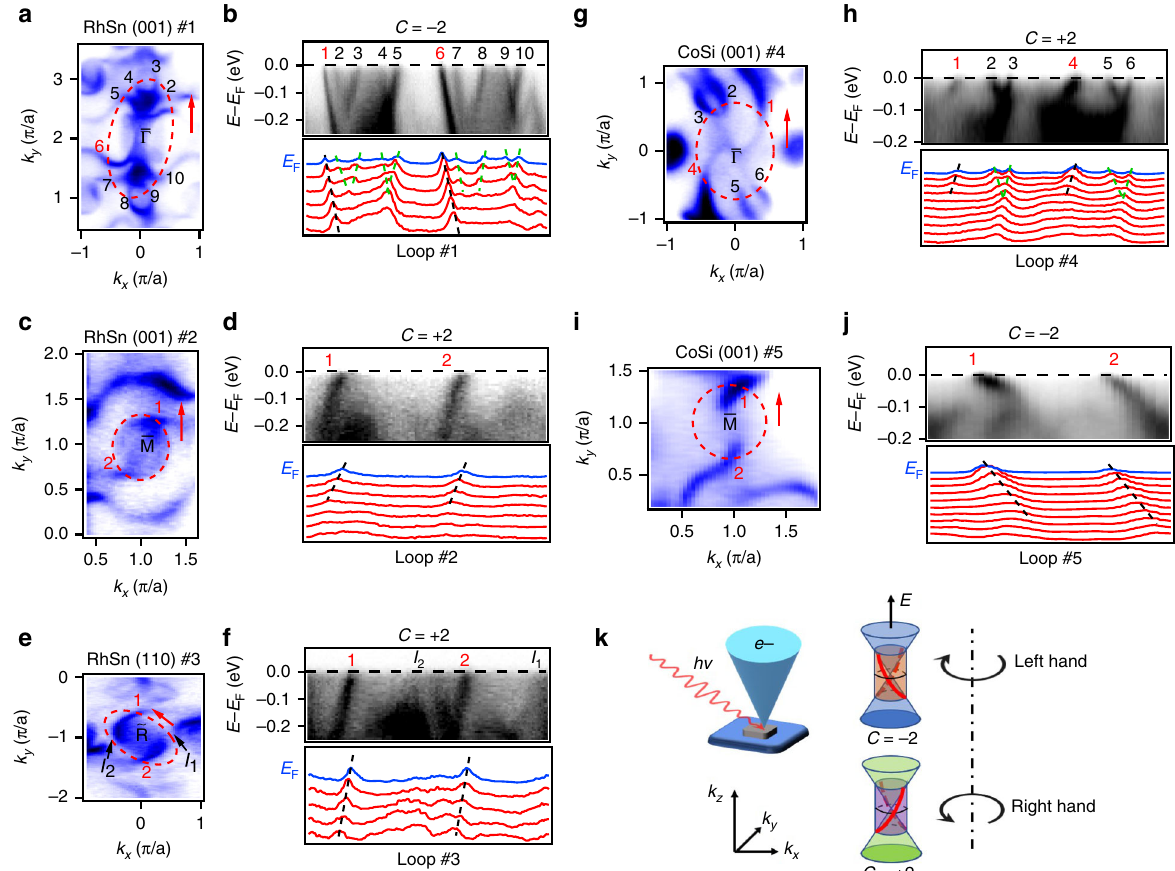
Fig. 4 Opposite handedness of helical surface states between CoSi and RhSn. a , c , e , g , i ARPES intensity maps at E F around (cid:1) Γ ( a ), (cid:1) M ( c ) and ~ R ( e ) of RhSn, and (cid:1) Γ ( g ) and (cid:1) M ( i ) of CoSi. The red dashed ellipses and arrows indicate the momentum paths and directions of loops #1 to #5. b , d , f , h , j ARPES intensity maps and corresponding MDCs showing the chiral surface bands on loops #1 ( b ), #2 ( d ), #3 ( f ), #4 ( h ) and #5 ( j ). The bands passing through E F are marked with numbers. The red and black numbers represent nontrivial and trivial bands, respectively. The weak intensities in f , which are related to the FSs around ~ M adjacent to loop #3, are marked as I 1 and I 2 . k Schematics of the relationship between chiral surface bands and chiral charges in the speci fi ed coordinate system. The ARPES data in a – h were collected with h ν = 75 eV, and those in i , j were collected with h ν = 110 eV. Note that the images for CoSi in g – j are mirrored as compared with those in Fig. 4 of ref. 31 , where k z was de fi ned as the inward normal of sample surface and is reserved to the current de fi